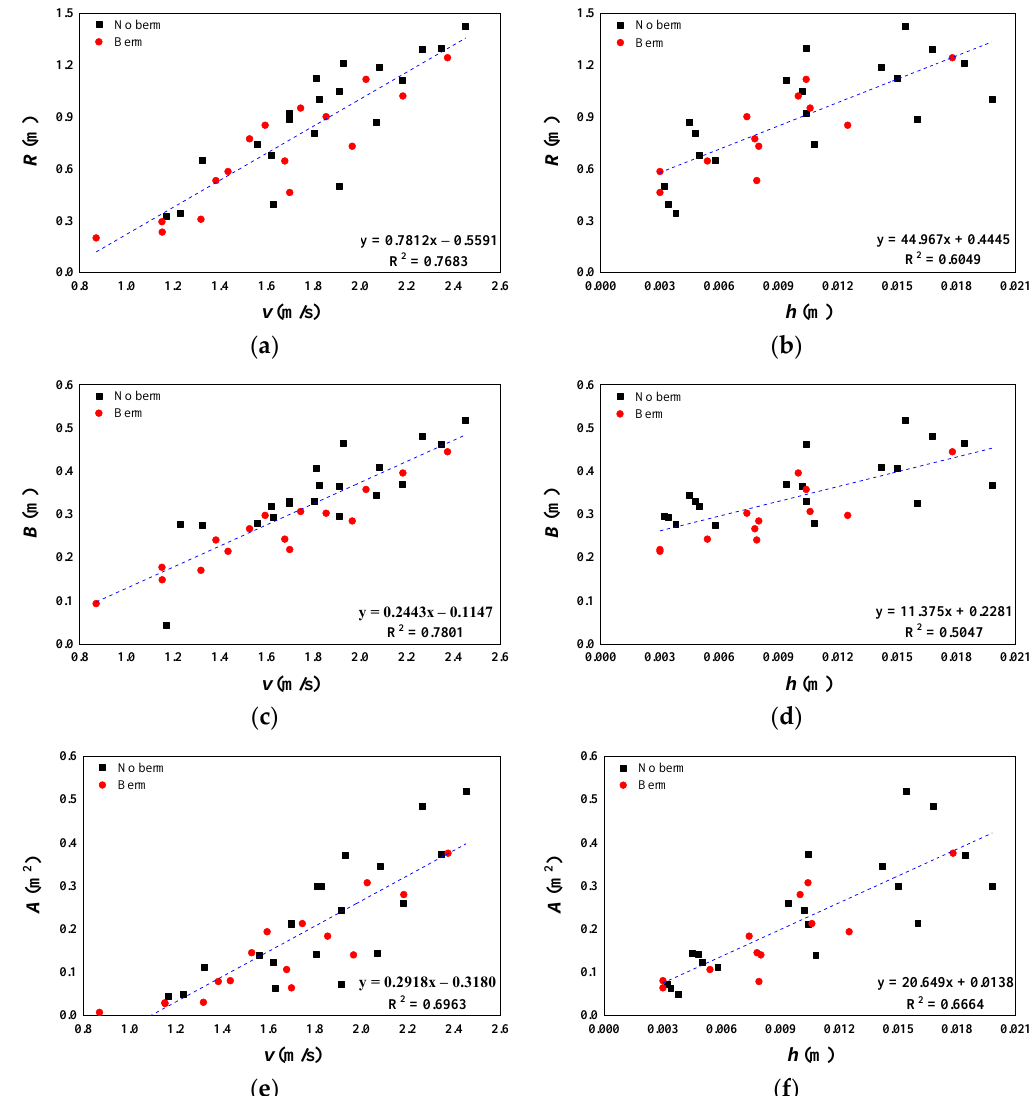
Figure 9. Relationships between flow characteristics and deposition characteristics of debris flow: ( a ) Relationship between flow velocity and runout distance; ( b ) relationship between flow depth and runout distance; ( c ) relationship between flow velocity and lateral width; ( d ) relationship between flow depth and lateral width; ( e ) relationship between flow velocity and deposition area; ( f ) relationship between flow depth and deposition area.